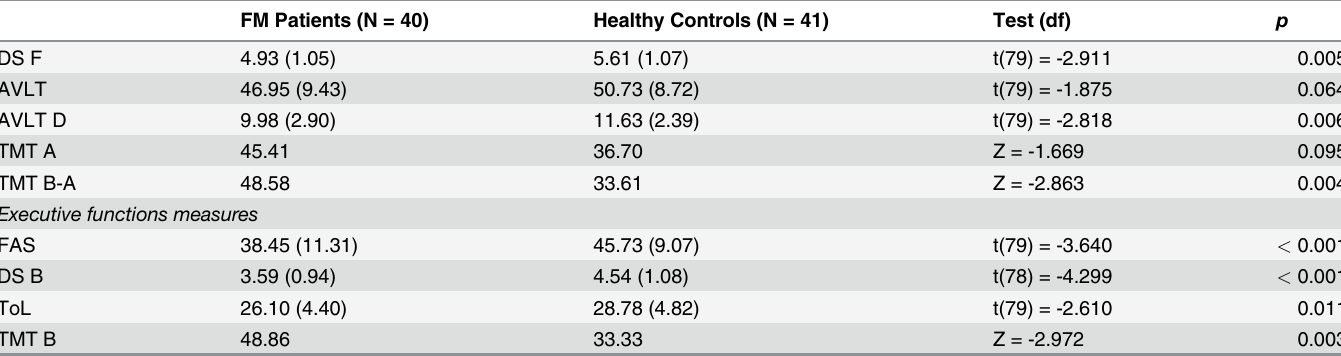
Table 2. Neuropsychological tests scores. Mean (SD) or mean rank, t-test or Mann – Whitney U test are listed. FM Patients (N = 40)